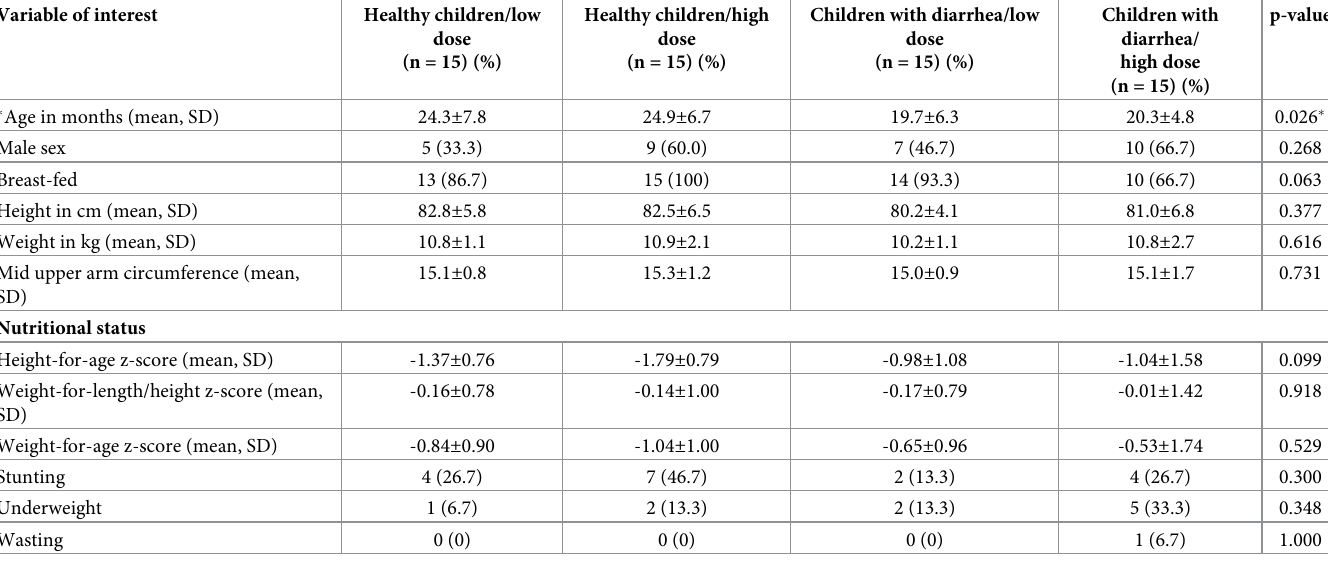
Table 1. Comparison of characteristics of healthy and diarrheal children with low (2.5 gm) and high (5 gm) dose of Fibersol-2 on first day.